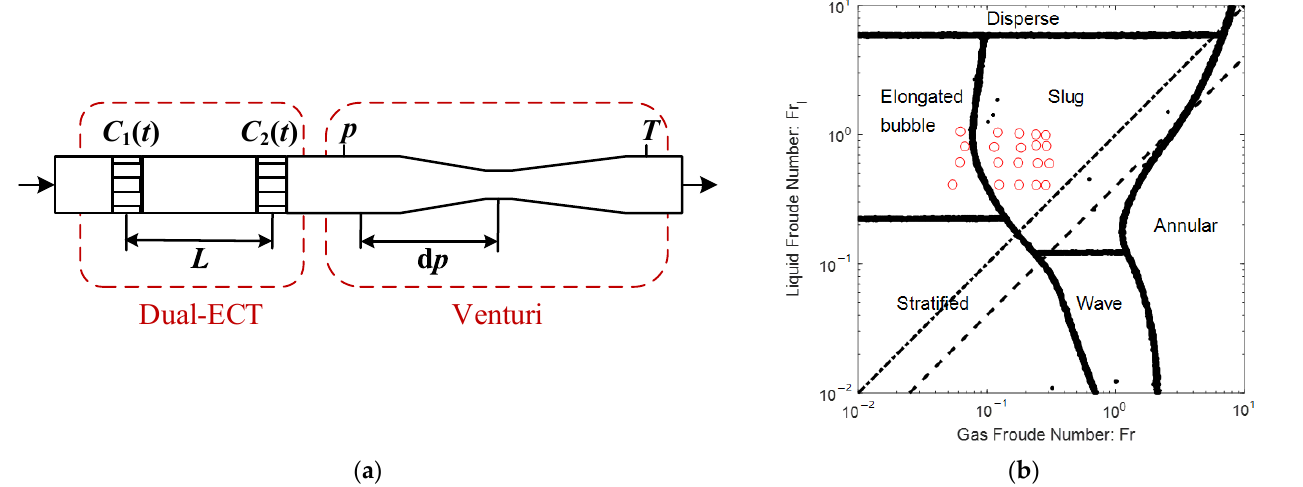
Figure 2. Schematic diagram of the multi-phase flowmeter (MPFM) and the collected test data: ( a ) MPFM; ( b ) test data. The dual-ECT module includes two planes of ECT sensors separated at a distance of L = 110 mm, and the detection frequency is f = 714 Hz. Each plane of ECT sensor includes 8 electrodes, so that 28 independent capacitance measurements can be obtained for each detection. The Venturi module includes a Venturi tube to measure the differential pressure d p , and a pressure and temperature sensor to measure p and T respectively. The diameters of the Venturi inlet and throat are D = 50 mm and d = 25 mm respectively,